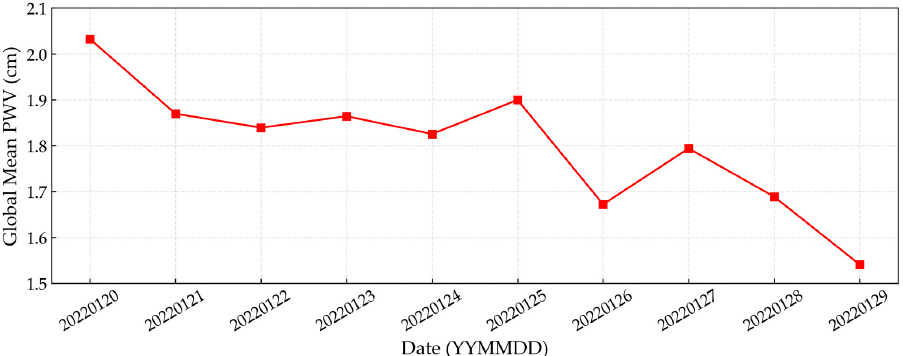
Figure 5. Global mean PWV variation from 20 January 2022 to 29 January 2022.